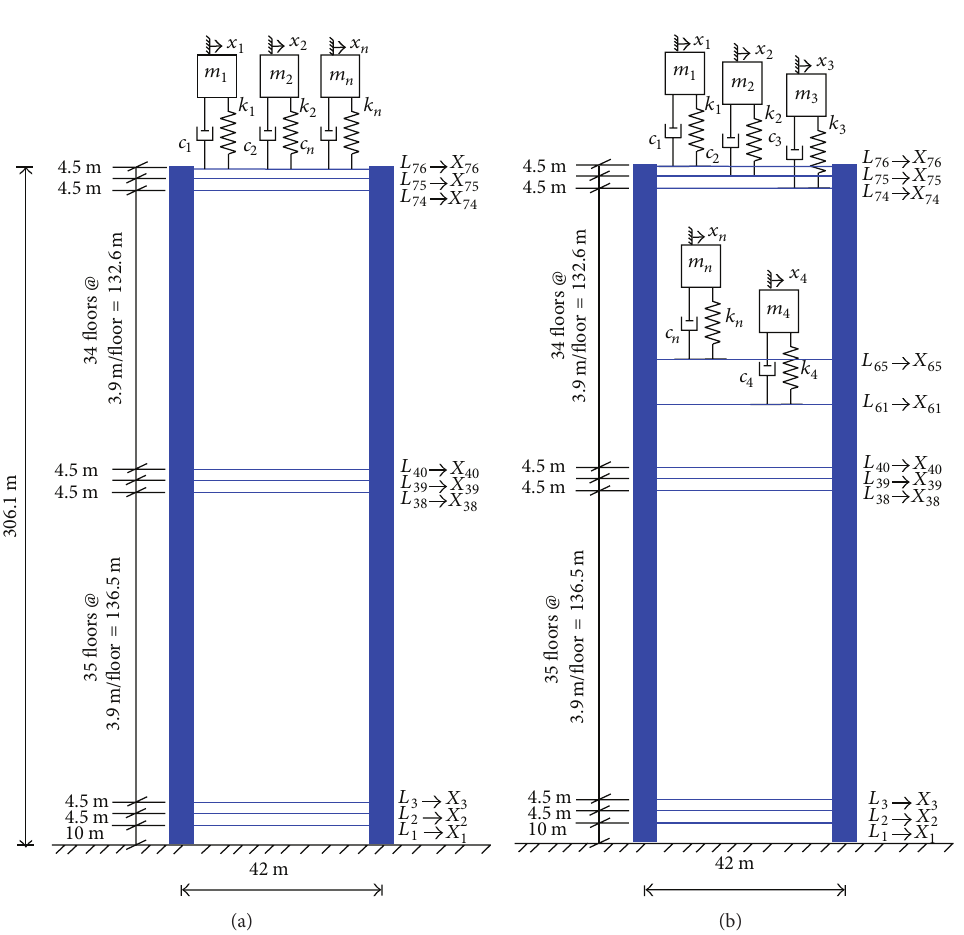
Figure 1: Model of 76-storey benchmark building installed with (a) MTMDs all at top floor, (b) d-MTMDs along height of the